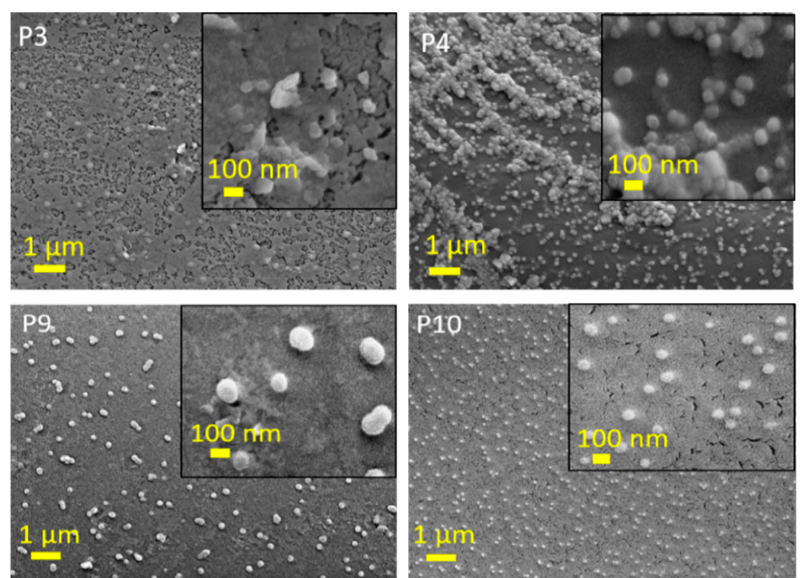
Figure 8. SEM images for PLA films layered first with 2% CH or QCH, followed by second layer in form of micro/nanoparticles of CH or QCH with embedded P. pavonica extract.